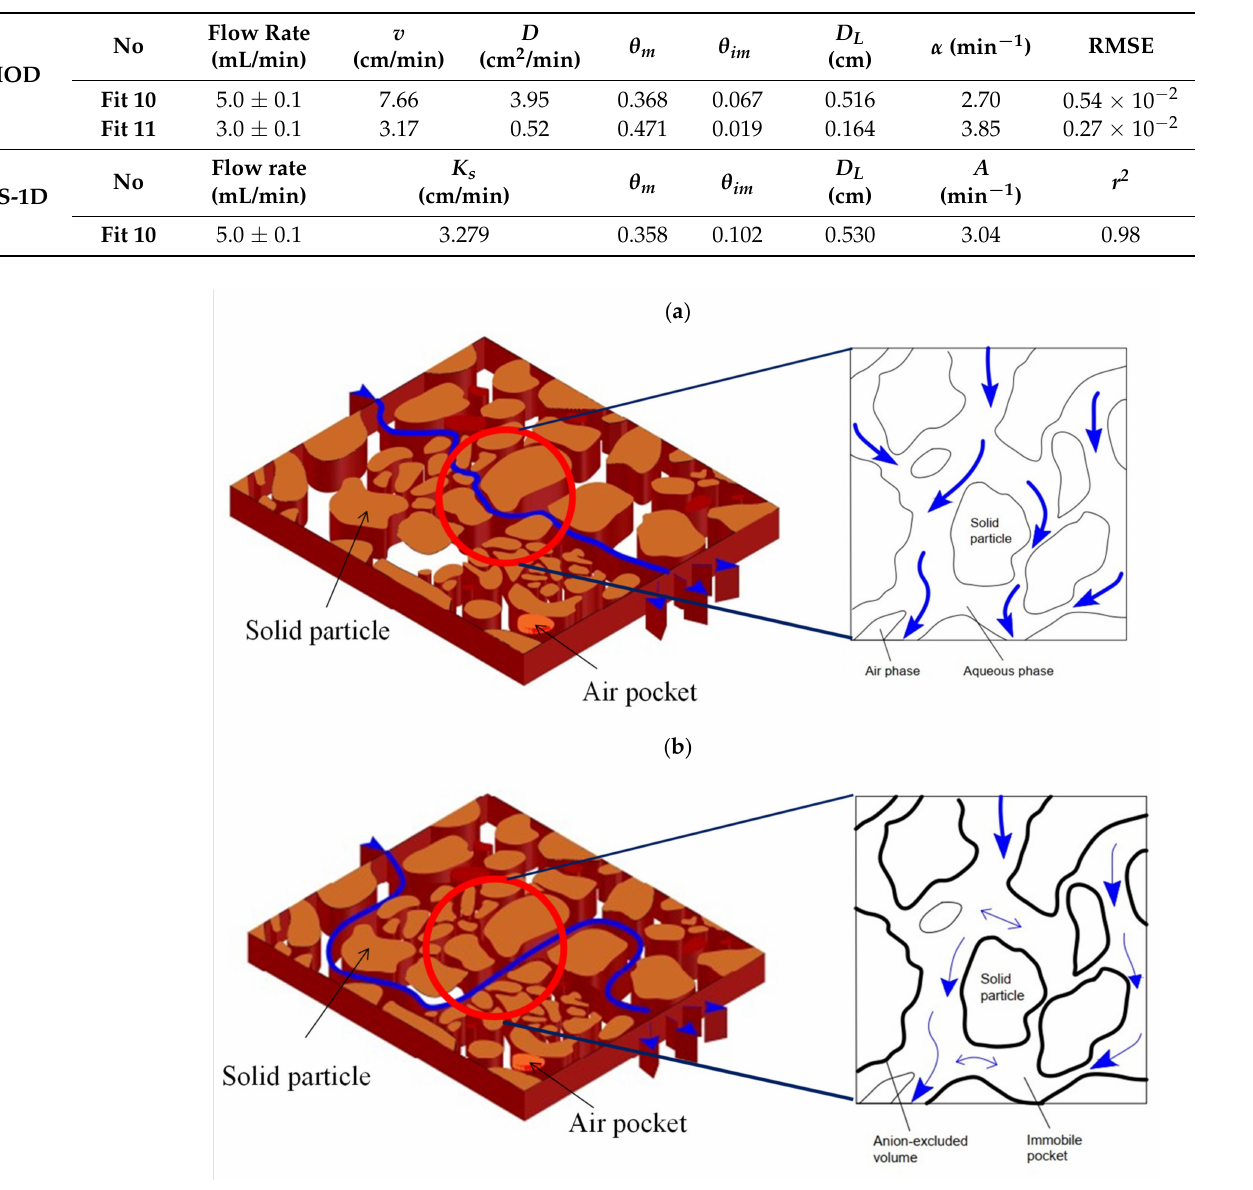
Table 6. The parameters for fitting I − BTCs (non-equilibrium model).